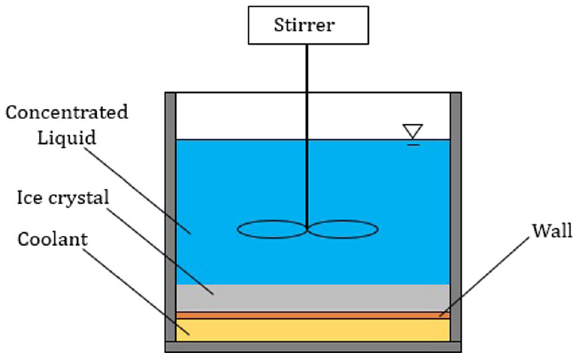
Fig. 4 Schematic of the progressive freeze-concentration process. A single ice crystal is grown unidirectionally on a cooling surface with liquid movement adjacent to the ice-liquid interface.